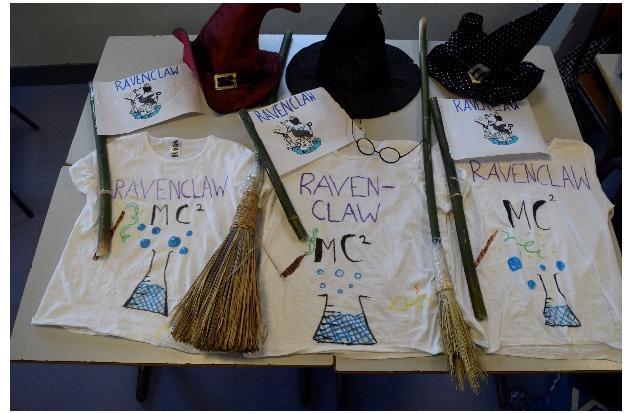
Figure 2. Ravenclaw team . Figure 2. Ravenclaw